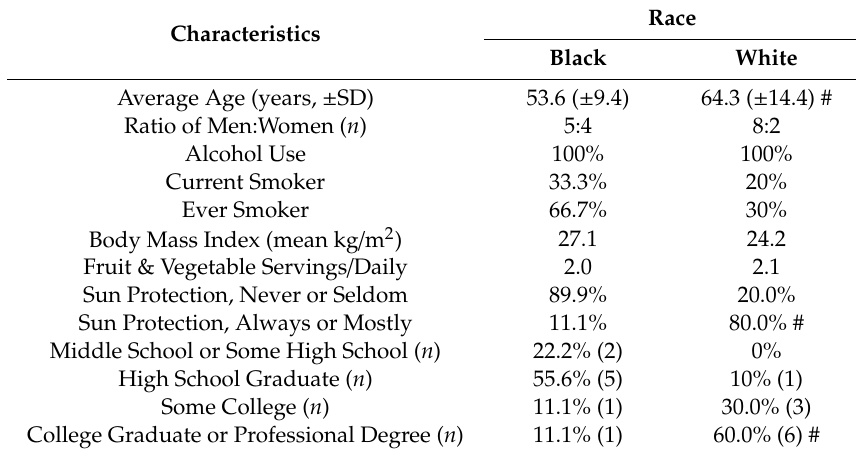
Table 1. Characteristics of newly diagnosed head and neck cancer patients. Characteristics